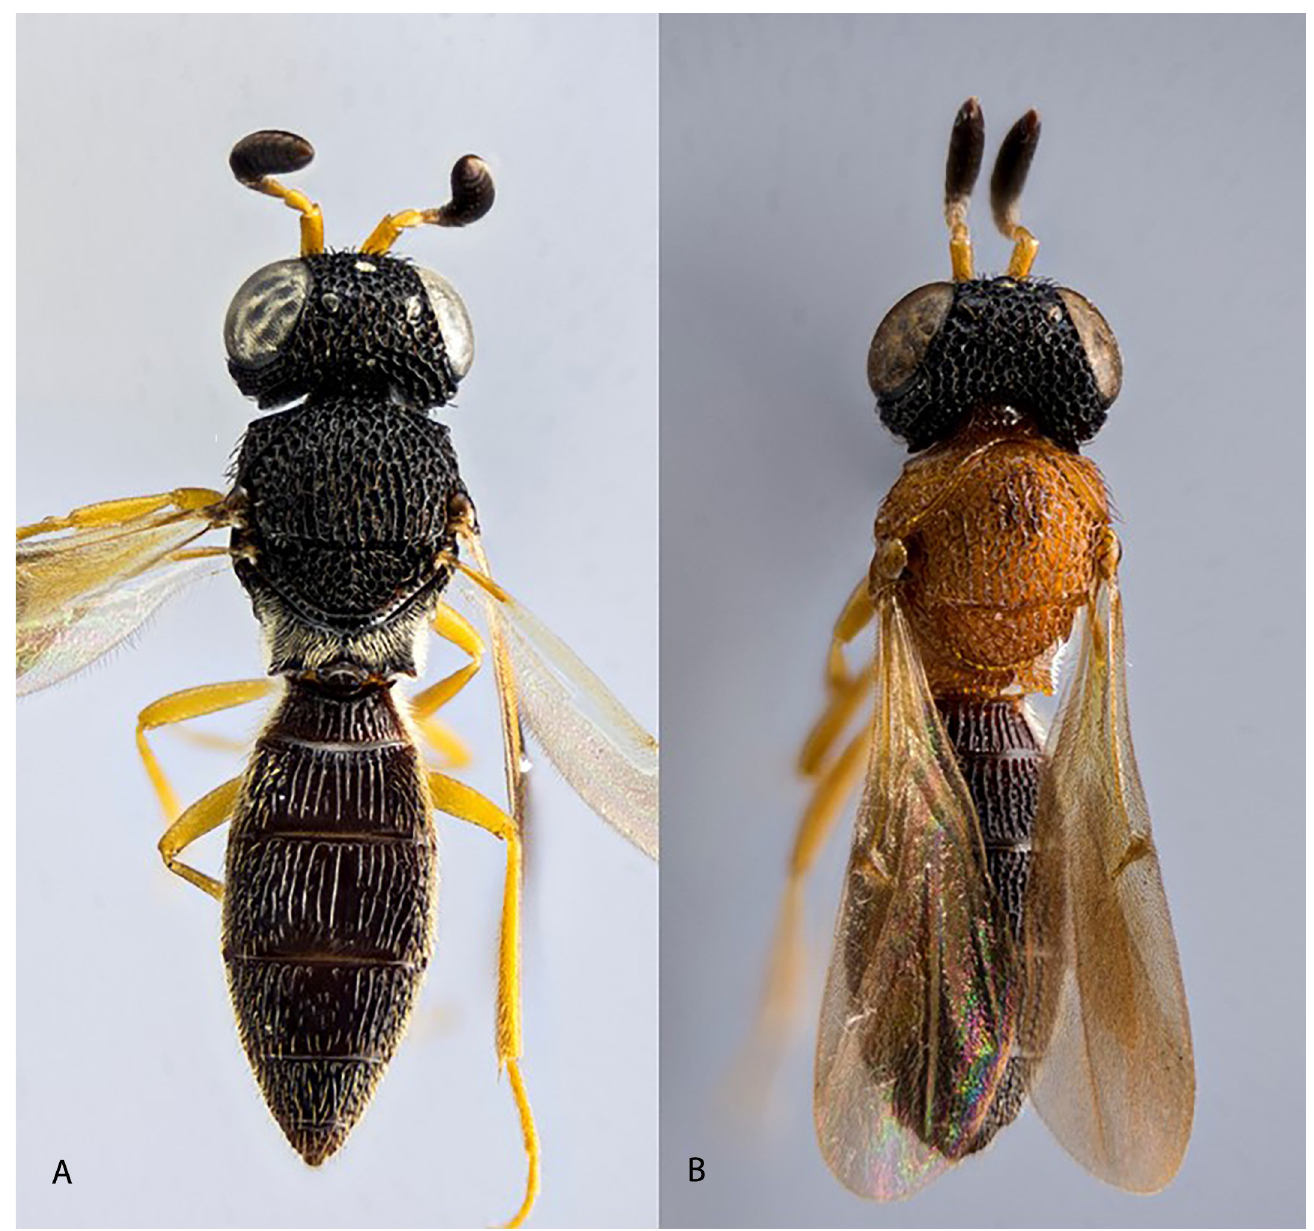
Fig 1. Two scelionid wasp color patterns within the same genus. Color patterns in the genus Scelio : black (A), and BOB (B). The focus-stacked macro photograph was obtained with a Reflex 850 camera coupled to a 20x microscope lens.